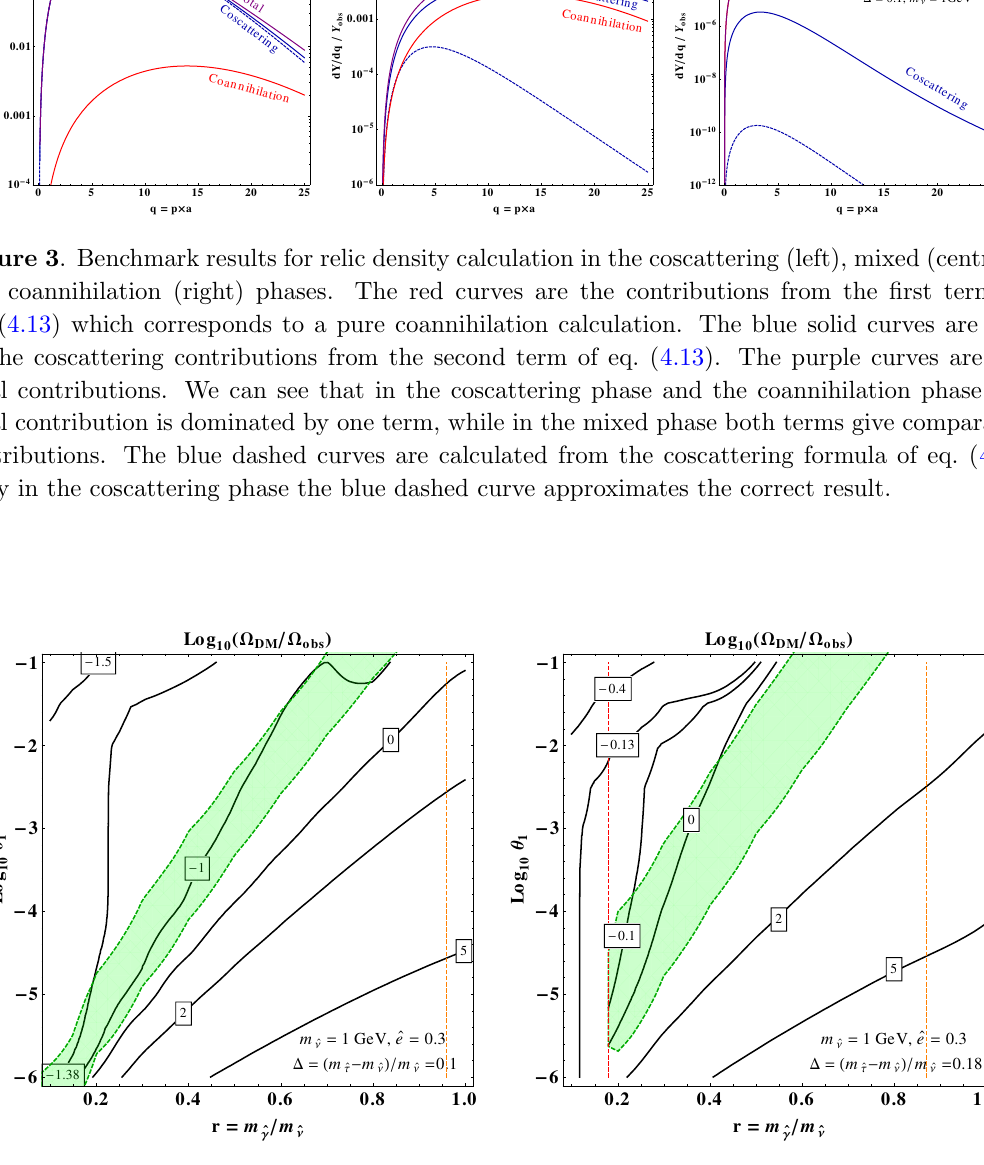
((cid:10) = (cid:10) OBS ) 10 . The S